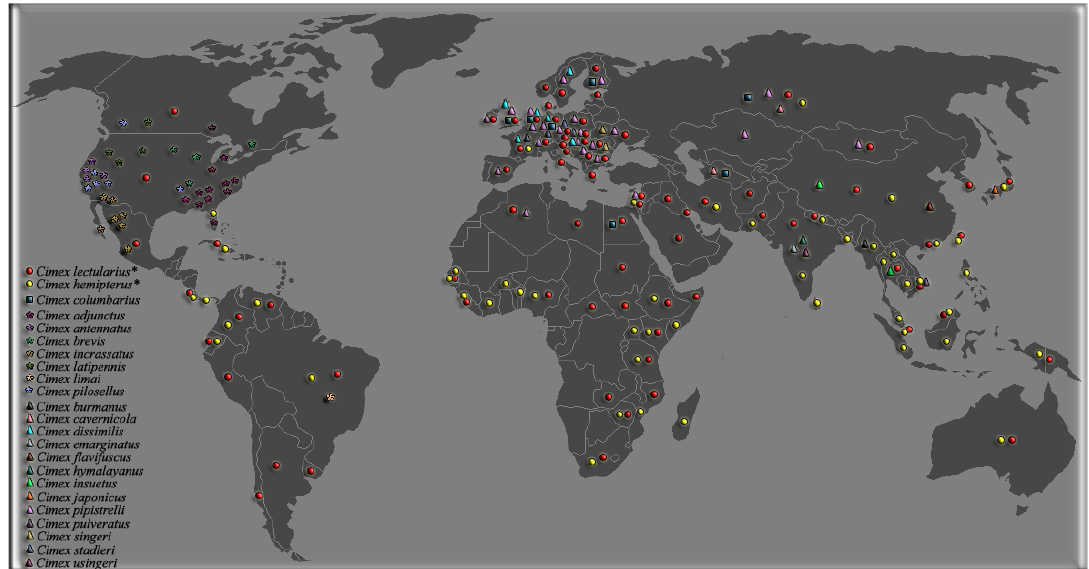
Figure 5. Global dispersion of 23 species belonging to the Cimex genus. The medically important species are indicated by an asterix. The countries with no pinpoint means no data is available. The pinpoint location represents only the presence of Cimex species with no indicative geographical position of the infestations.